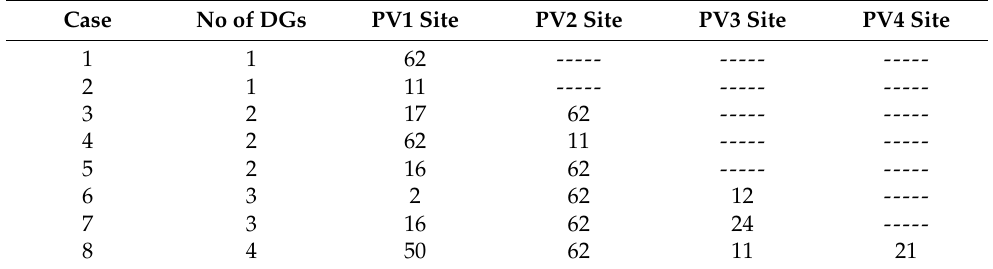
Table 5. Optimal photovoltaic (PV) DG locations for the IEEE 69-bus test system using GWO.